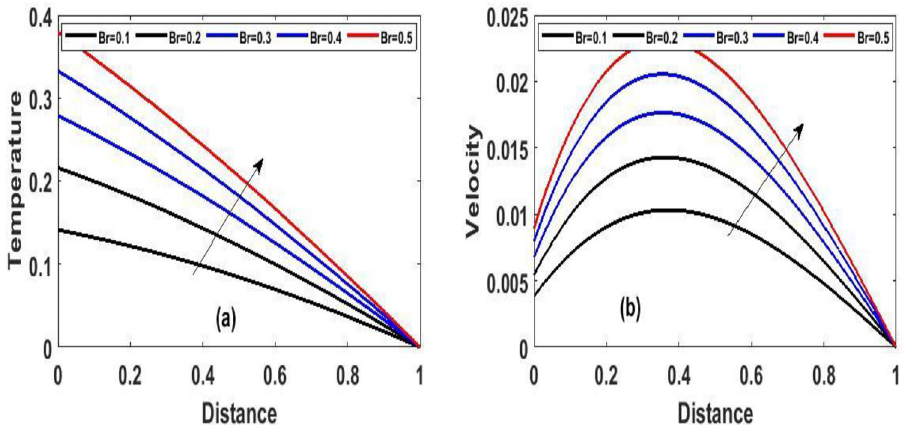
Figure 4. The effect of variation of Br for Temperature and velocity steady state.